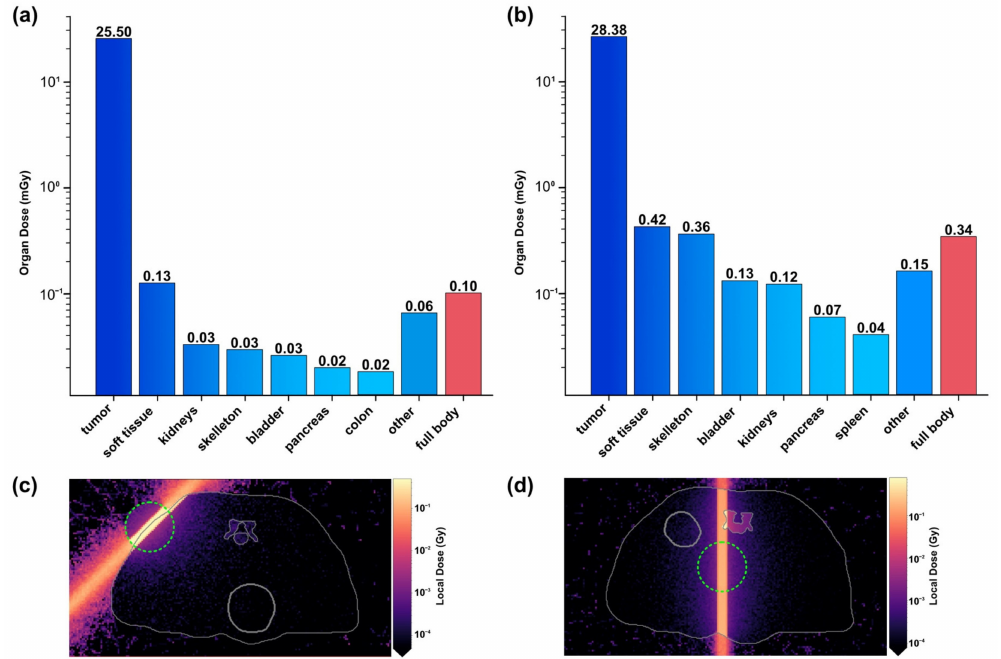
Figure 5. Dose deposition when imaging Au-labelled subcutaneous ( a – c ) and central ( b – d ) targets. ( a , b ) Organ doses and full body dose. ( c , d ) Transversal slice of the mouse voxel model showing the local dose at beam level. The target is highlighted by a green